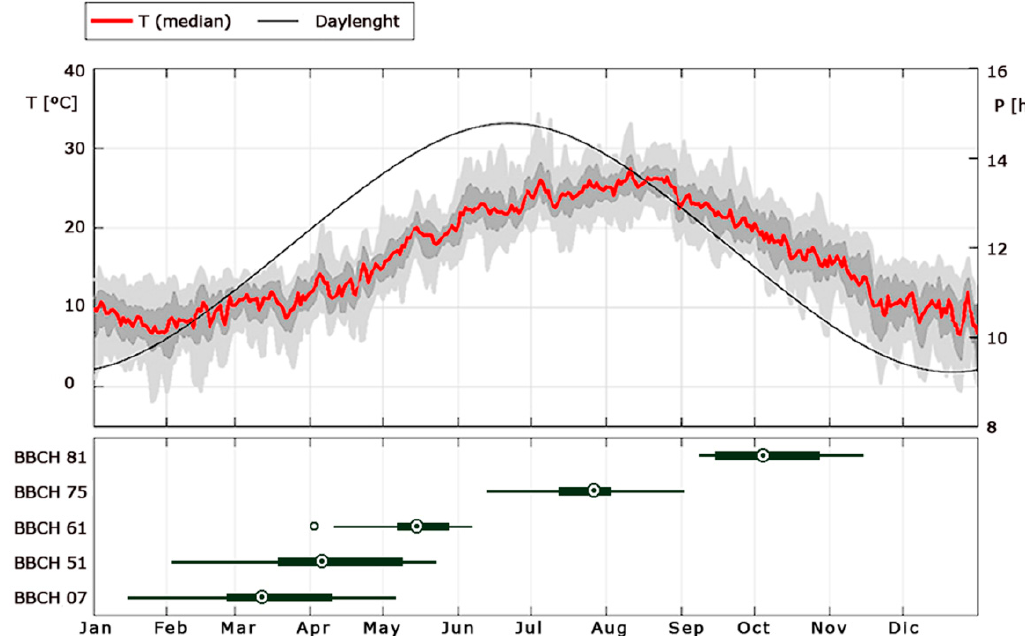
Figure 2. Upper panel: average daily temperatures (red line as median, dark grey shadows as interquartile range, light grey shadow as 5th to 95th percentile) and daylength (black line) between experimental sites (Table 1) during the period 1997–1999. Bottom panel: distributions of phenological observations (DOY) for the representative events BBCH 07, 51, 61, 75, and 81 (definitions in Table 1) among experimental sites, period 1997–1999. In the boxplot the central dot is the median, the boxes are the 25th and 75th percentiles, whiskers extend to the 10th and 90th percentiles. Empty dot: outlier.